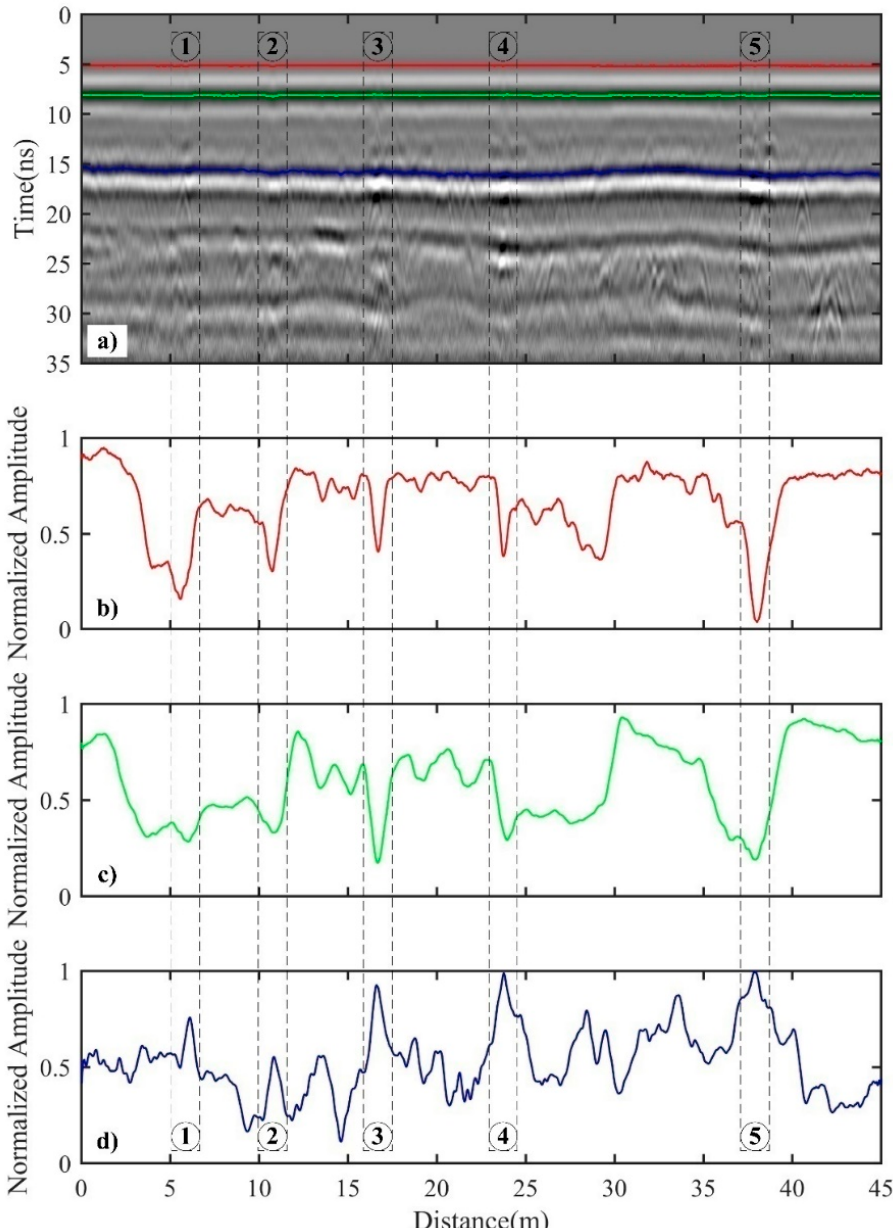
Figure 9. ( a ) The observed GPR profile using 400 MHz ground-coupled antenna. ( b – d ) the normalized amplitude of the red, green and blue lines in ( a ), respectively. - The interpreted cracks based our analysis.